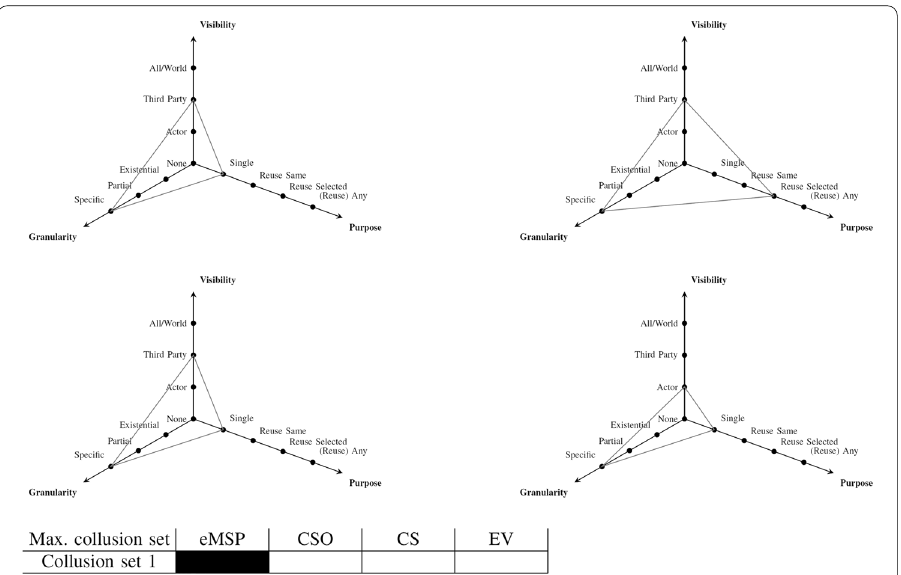
Fig. 9 Privacy dimensions and collusion sets for (Mustafa et al. 2015) for data items (i) pseudonym (top left), (ii) charging time and price/consumption report (top right), (iii) grant or reject (bottom left), and (iv) charging parameters (bottom right). Collusion set 1 refers to the mapping between pseudonyms and the EV’s